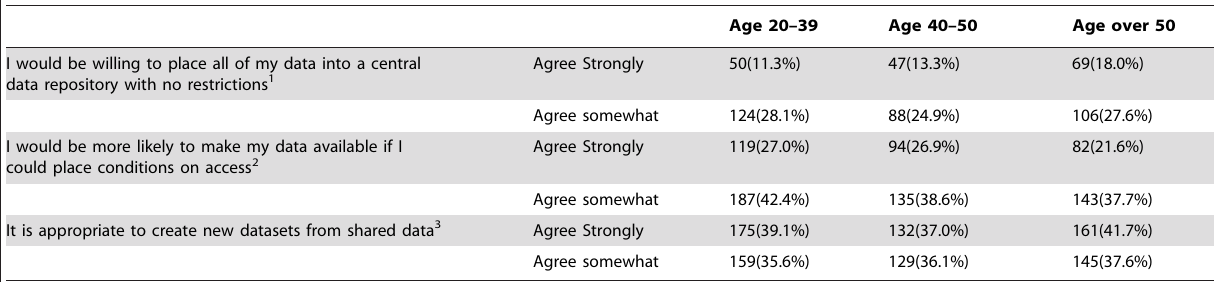
Table 25. Data sharing by age group.